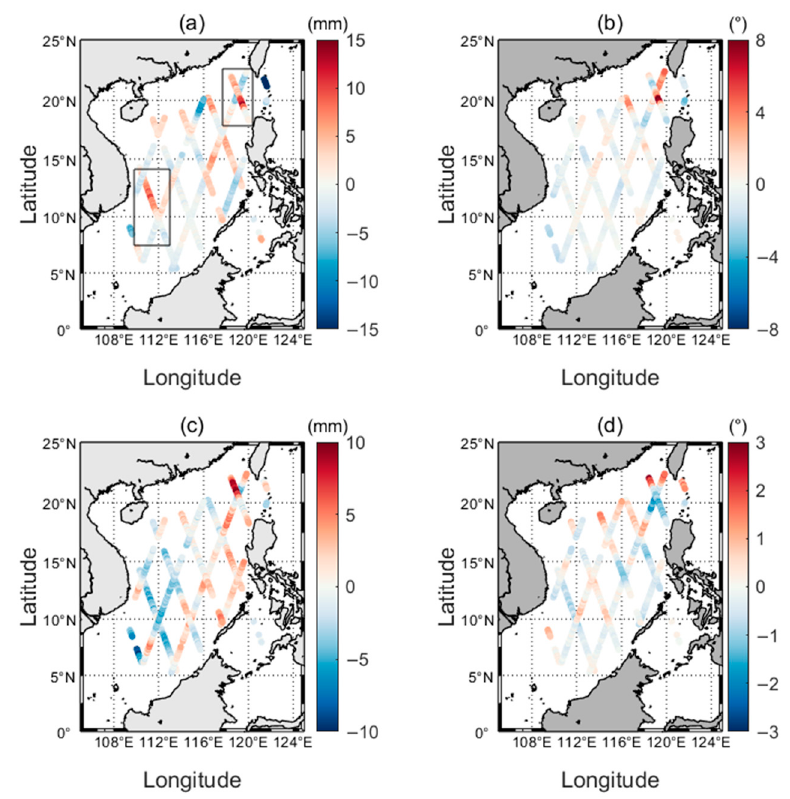
Figure 8. Spatial distribution of M 2 and O 1 tidal amplitude differences and phase differences before and after the MVC in the South China Sea: ( a ) the amplitude differences of M 2 (the west of Luzon Strait and the western boundary of the deep ocean basin are marked in the map); ( b ) the phase differences of M 2 ; ( c ) the amplitude differences of O 1 ; ( d ) the phase differences of O 1.